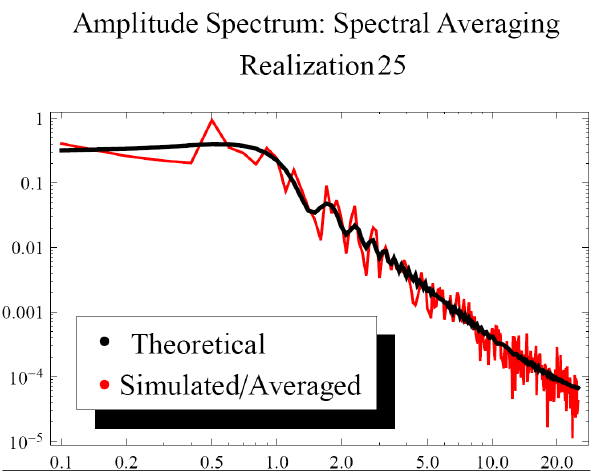
Fig. 21. Distribution of ratios for the five averaged amplitude fre- quency spectra shown in Fig. 19, above. Note that the theoretical density function is from a gamma distribution.